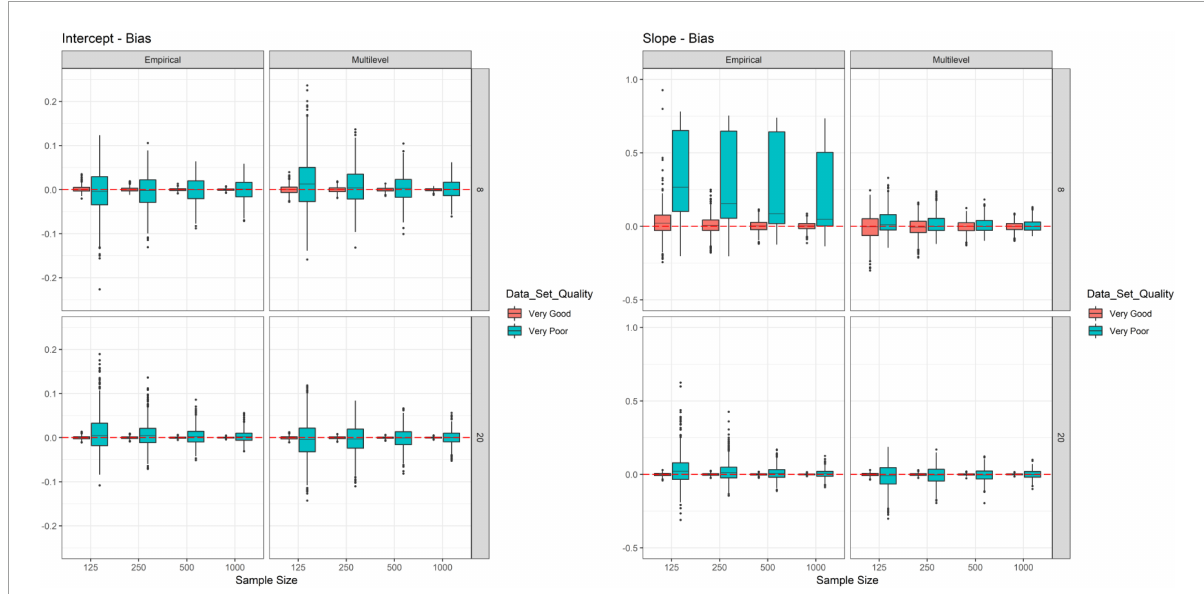
FIGURE3 Simulation study–bias results. Each box represents one cell of the simulation design and is based on 1,000